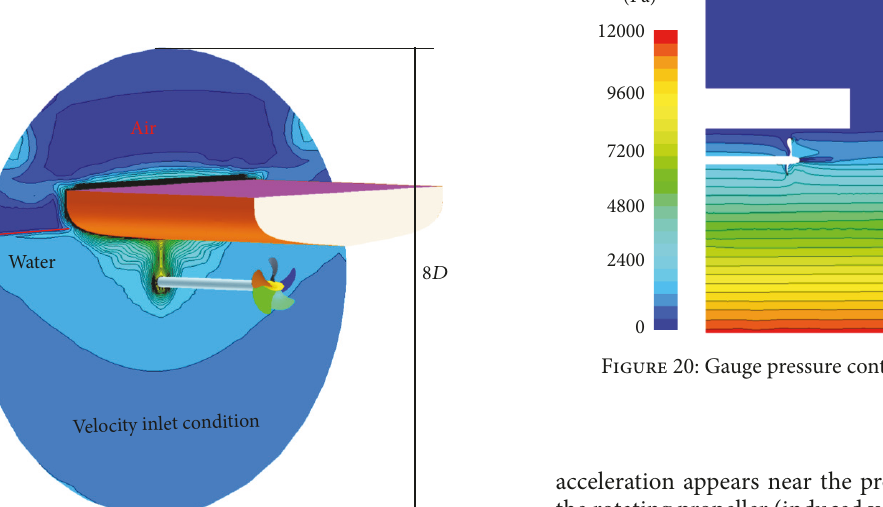
Figure 17: Computational domain for propeller simulations under nonuniform ship’s wake.